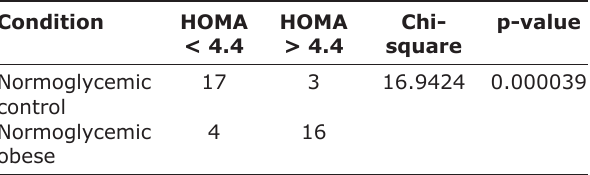
Table-1: Statistical analysis Chi-square between HOMA non-linear insulin resistance and